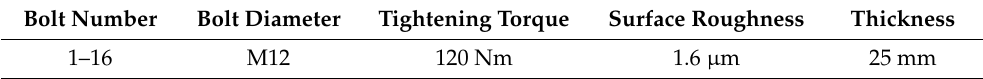
Table 10. Connect condition of the bolts.